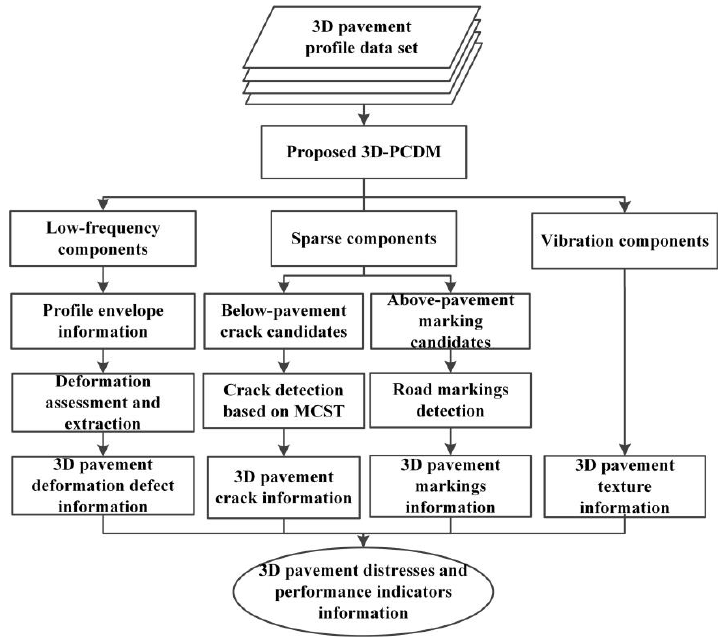
Figure 7. Validation methods of decomposition component effectiveness.